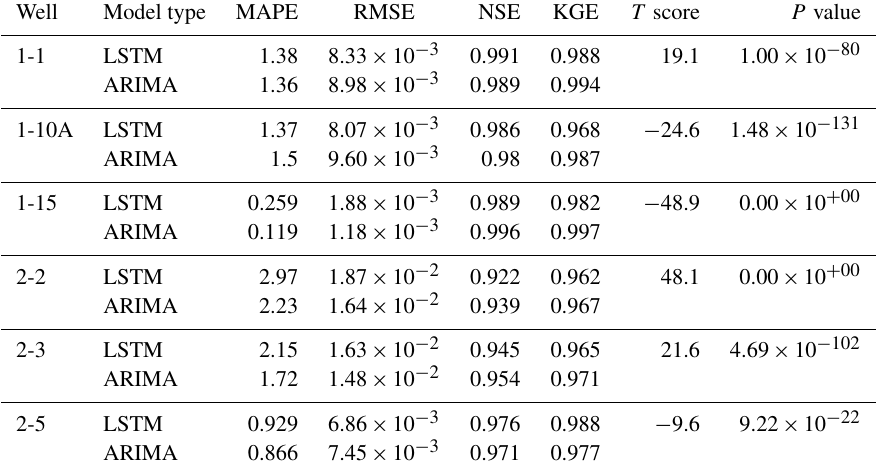
Table 2. Comparison of single-well LSTM and ARIMA models for a 24h synthetic gap in the SpC data of the test set for each well. The models are the same as those used in Fig. 8. The calculated statistics are as follows: the mean absolute percentage error (MAPE), the root- mean-squared error (RMSE), the Nash–Sutcliffe model efficiency coefficient (NSE), and the Kling–Gupta efficiency (KGE). The T score and p value are calculated for the relative errors of the two models per